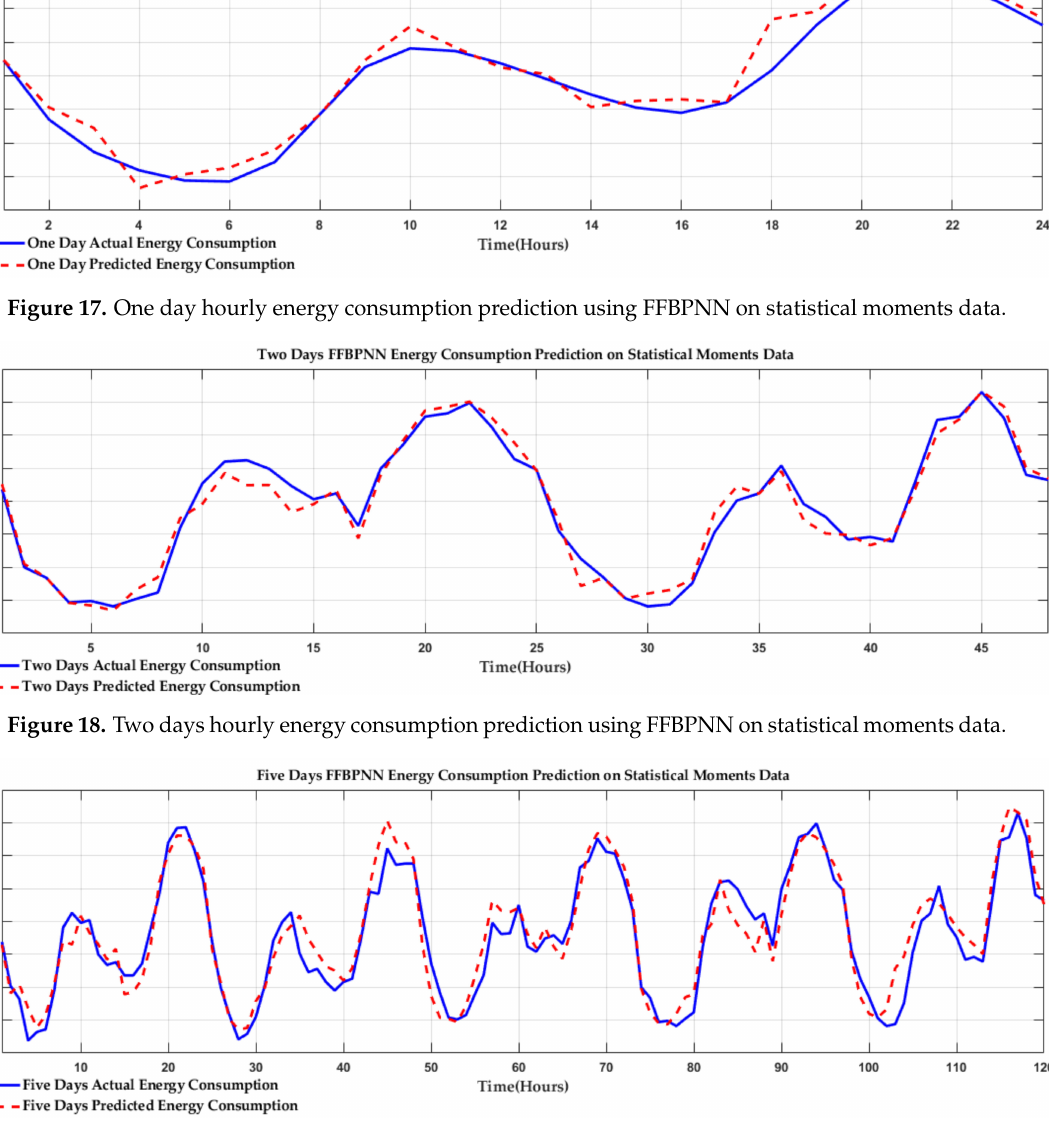
Figure 19. Five days hourly energy consumption prediction using FFBPNN on statistical moments